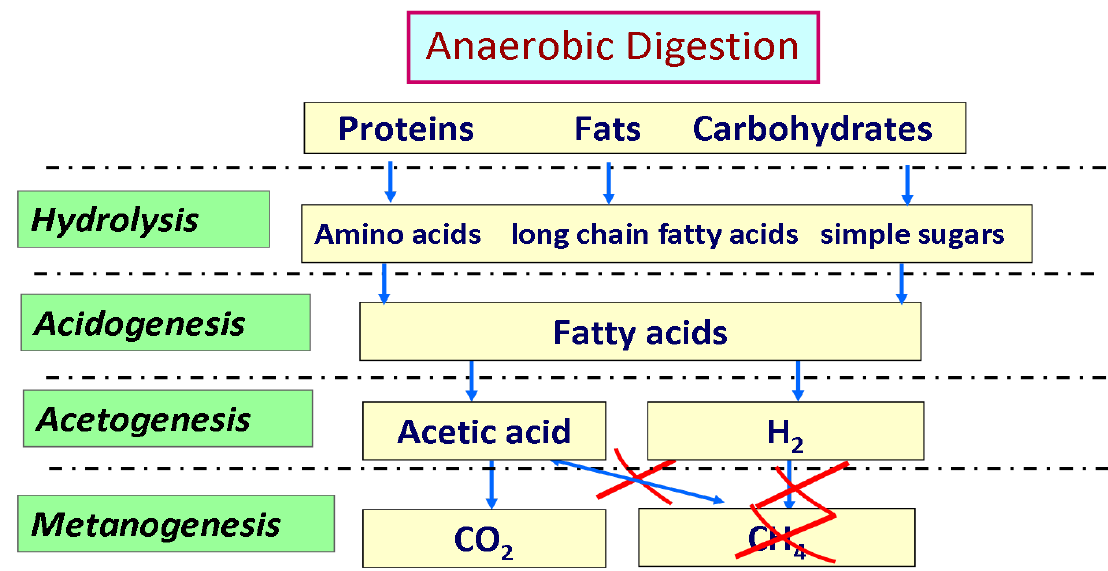
Figure 11. Overview of the metabolic pathway leading to the formation of hydrogen in anaerobic digestion